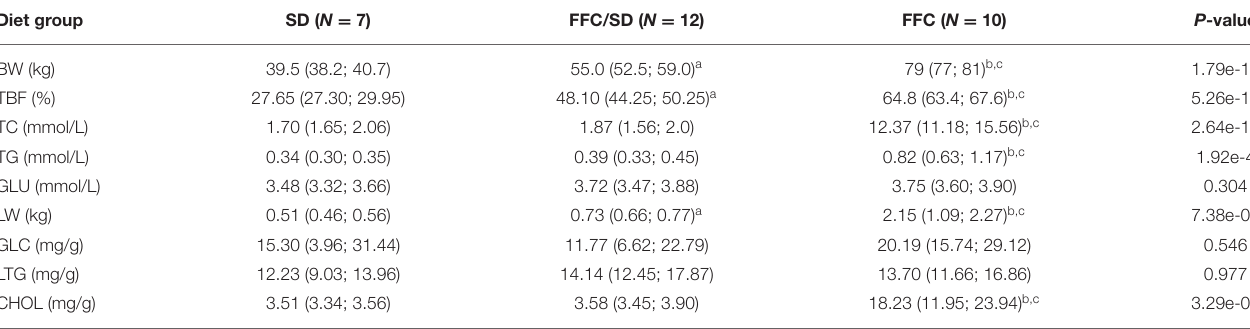
TABLE 1 | Morphometric and metabolic features of the minipigs.